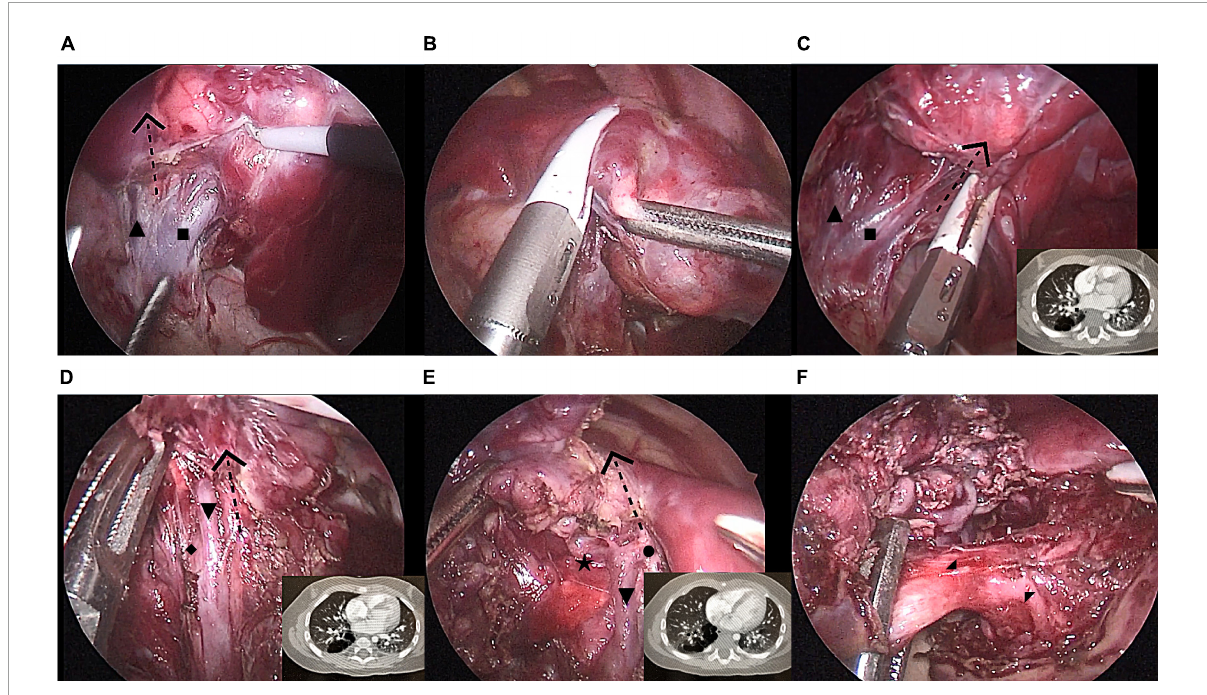
FIGURE1 Modified thoracoscopic wedge resection of limited peripheral lesions in the right S10. (A) Separating the inferior pulmonary vein and its branches [V6, common basal vein (CBV)] and determining the left boundary of the lesion (V6); (B) Cutting and closing the left lesion boundary with LigaSure TM along V6; (C) Cutting and closing the lower part of the right lesion boundary with LigaSure TM along CBV; (D) Cutting and closing the middle part of the right lesion boundary with LigaSure TM along V9 and V10; (E) Cutting and closing the upper part of the right lesion boundary with LigaSure TM along V9; (F) Separation of the diseased bronchus and artery (B10 and A10) entering the lesion. CBV, common basal vein: (cid:4) , V 6 : (cid:78) , V 9 + 10 : (cid:72) , V 8 : (cid:7) , V 9 : • , V 10 b : (cid:70) , B 10 : , A 10 :